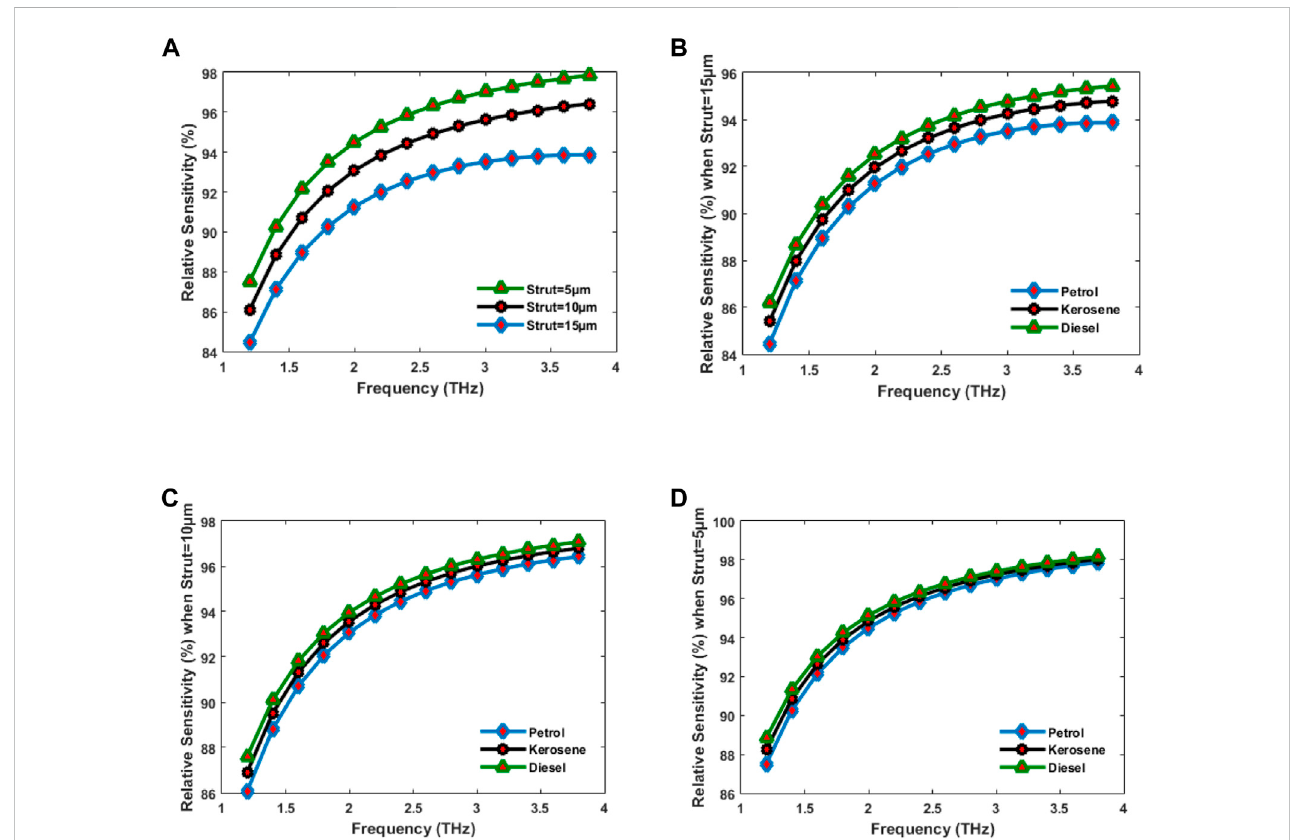
Sensitivityvs.operatingfrequency. (A) Core fi lledwithPetrolatvariousstrut. (B) Core fi lledwithallpetrochemicalsatstrutof15 μ m. (C) Core fi lledwithall petrochemicals at strut of 10 μ m. (D) Core fi lled with all petrochemicals at strut of 5 μ m.